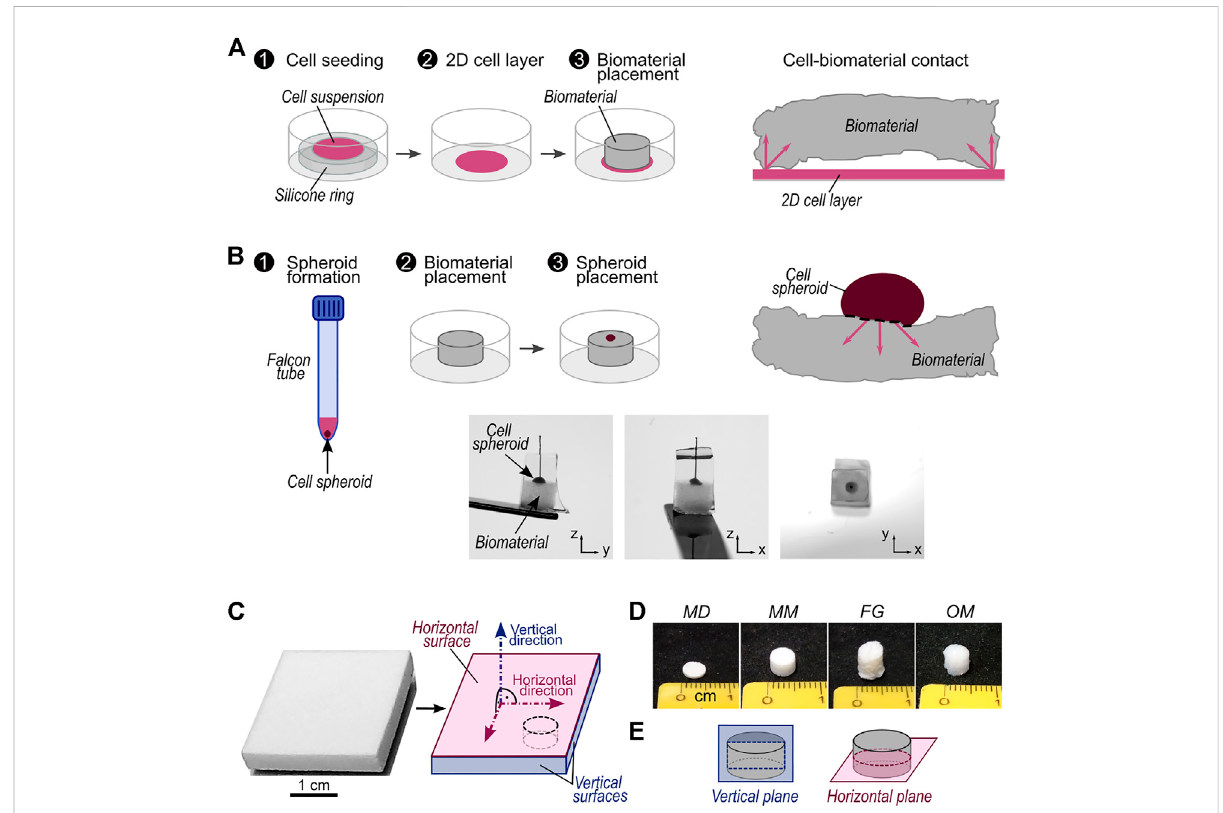
FIGURE 1 Description of investigated migration assays and biomaterials. (A) Schematic work fl ow of migration assay with 2D cell source and representation of contact between 2D cell source and a biomaterial with non-planar surfaces. The arrows highlight possible directions of cellular migration into the biomaterial; (B) top: schematic work fl ow of migration assay with 3D cell source and representation of contact between 3D cell source and a biomaterial with non-planar surfaces. The arrows highlight possible directions of cellular migration into the biomaterial. Bottom: representativepicturesofacell spheroid placed onabiomaterial sample.The sample isembeddedin solidi fi edsucrose/gelatin andapiece ofsuture material marks the center of the cell spheroid (see Materials and Methods ); (C) Exemplary picture of a biomaterial sheet as delivered by the manufacturer (here Mucomaix) and its schematic representation with indications of the vertical and horizontal surfaces and directions. All vertical surfaces are considered equivalent. The black dashed line marks a representative cutting line for cylindrical samples; (D) representative pictures of cylindrical samples of MD, MM, FG, and OM; (E) Illustration of vertical and horizontal planes in cylindrical